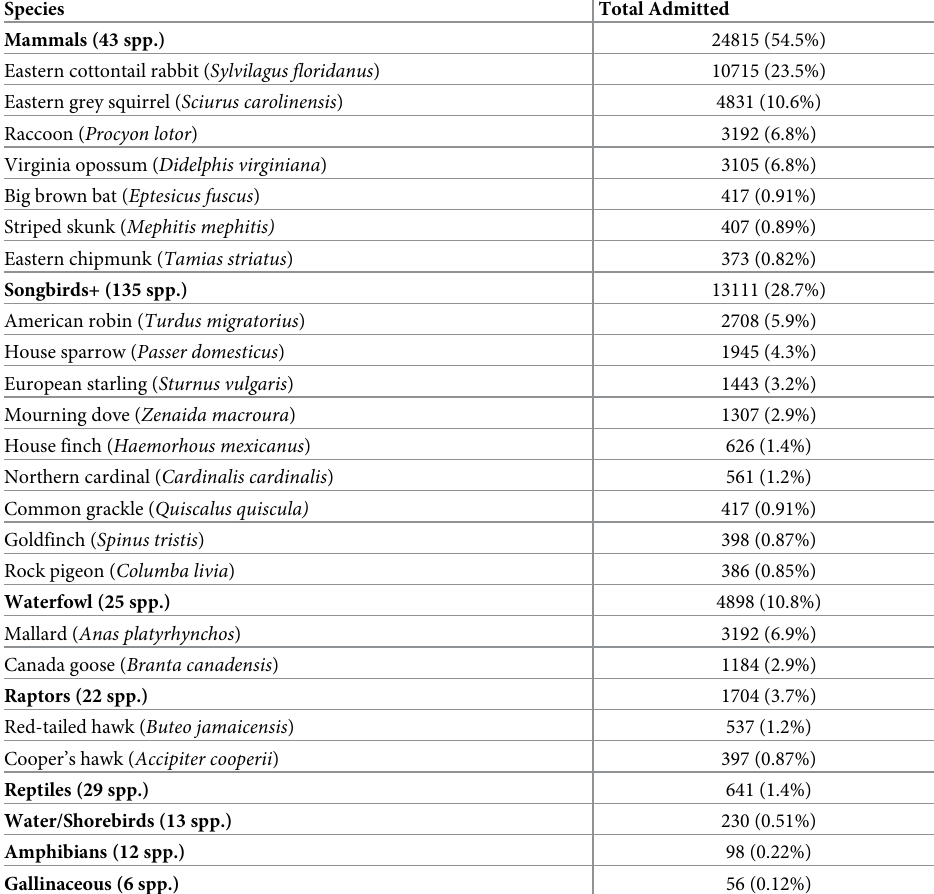
Table 1. The total number and percentage of all admitted cases represented by each taxonomic group, and the total number and percentage of all admitted cases represented by the top 20 most frequently admitted species. Species Total Admitted Mammals (43 spp.) 24815 (54.5%) Eastern cottontail rabbit ( Sylvilagus floridanus